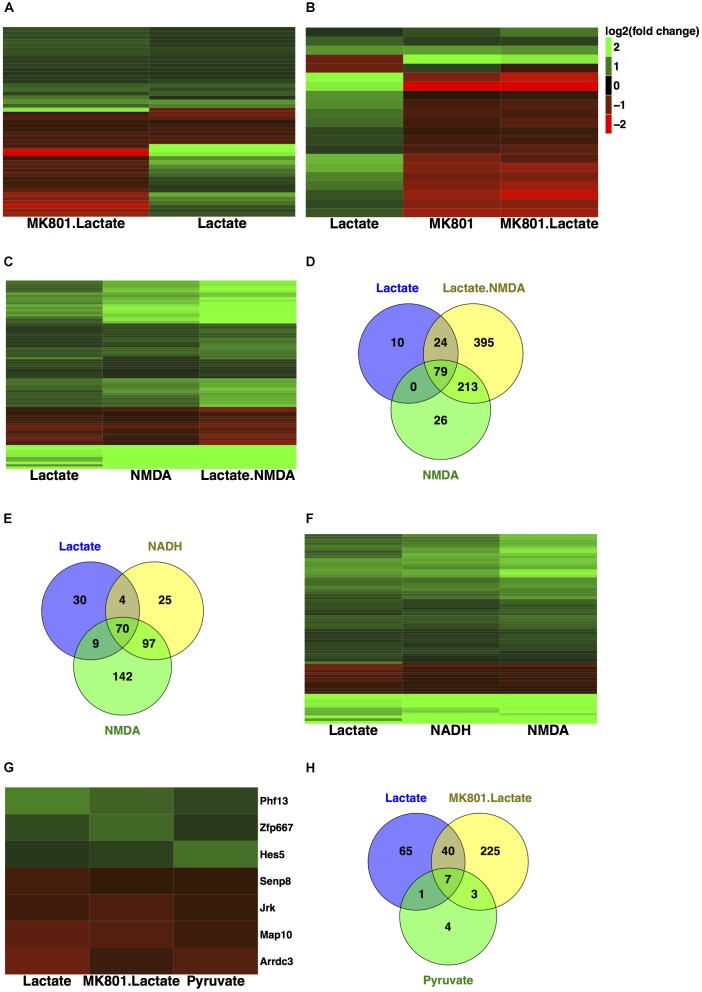
Comparison of transcriptional responses to L-lactate, MK-801, NADH, NMDA, and pyruvate. (A) Heatmap with genes regulated by L-lactate in absence and presence of MK-801 channel blocker in cortical neurons. Colors red and green indicate down-regulated and, respectively, up-regulated genes with the corresponding log2(fold change) values. (B) Heatmap with genes regulated by L-lactate, MK-801/L-lactate co-treatment and MK-801 alone. (C) Heatmap with genes modulated by L-lactate, NMDA, and L-lactate/NMDA co-treatment, after 1 h. All genes represented in the heatmap are differentially expressed in each of the treatment conditions (q < 0.05). (D) Total numbers of genes differentially expressed in response to L-lactate, NMDA, and L-lactate/NMDA co-treatment. (E) Total numbers of genes differentially expressed in response to L-lactate, NADH, and NMDA. (F) Comparison of transcriptional responses to L-lactate, NADH, and NMDA after 1 h. (G) Heatmap depicting genes modulated by L-lactate alone, L-lactate/MK-801 co-treatment, and pyruvate, after 1 h. (H) Venn diagram depicting total number of genes modulated by L-lactate, MK-801/L-lactate co-treatment and pyruvate.